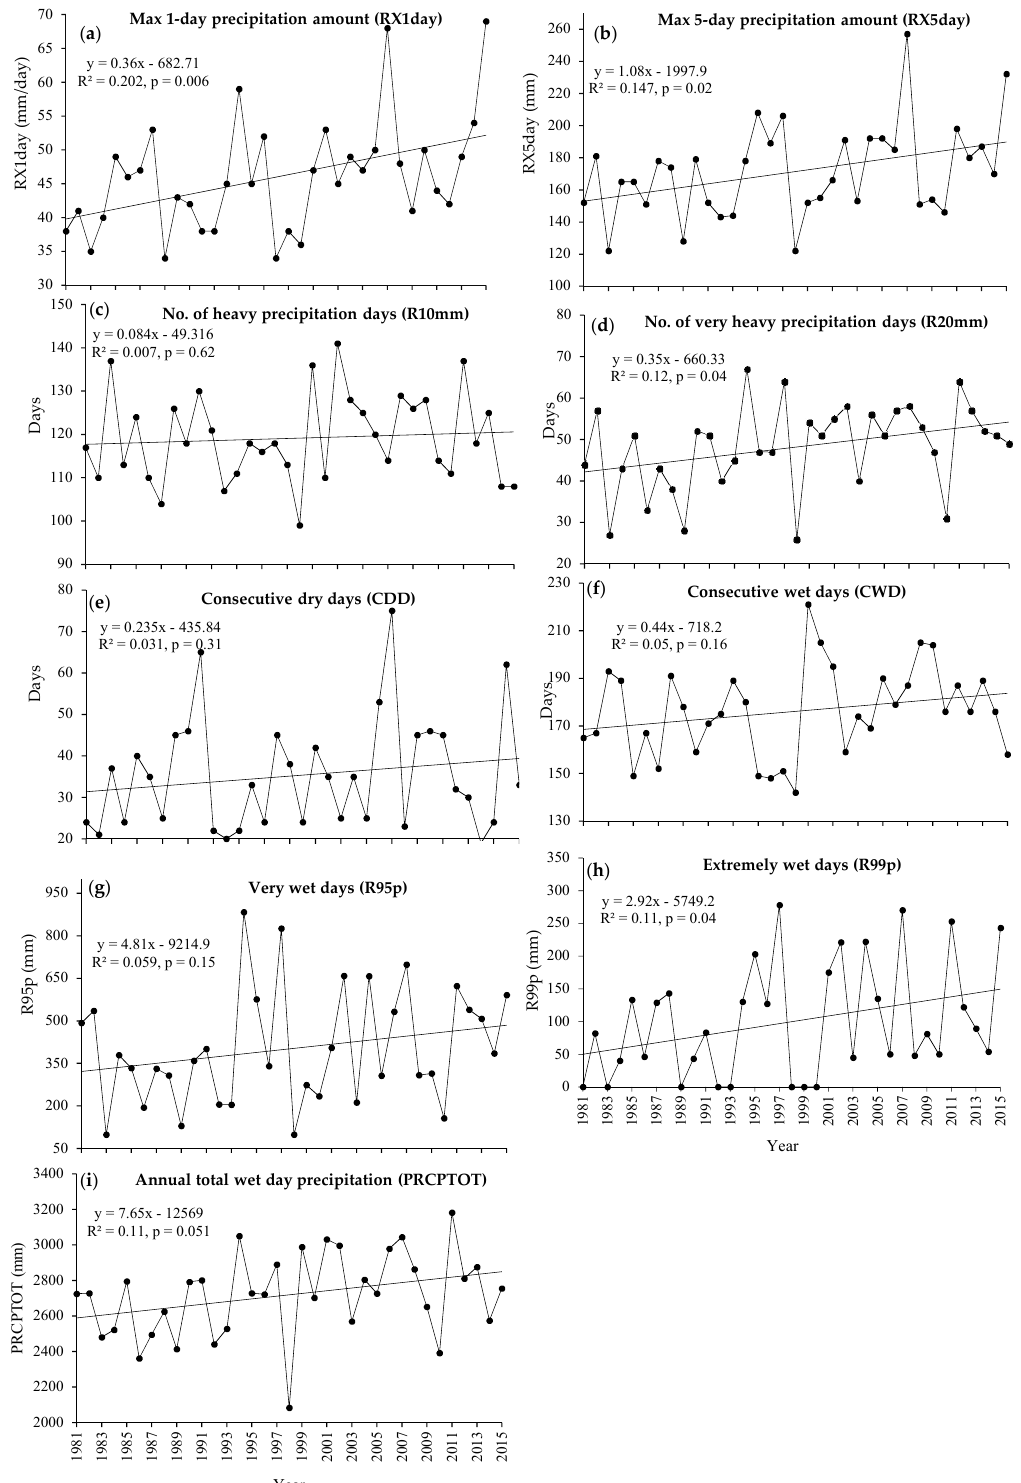
Figure 8. Annual trends of national averaged precipitation indices ( a ) RX1day; ( b ) RX5day; ( c ) R10mm; ( d ) R20mm; ( e ) CDD; ( f ) CWD; ( g ) R95p; and ( h ) R99p; and ( i ) PRCPTOT for the period 1981–2015.